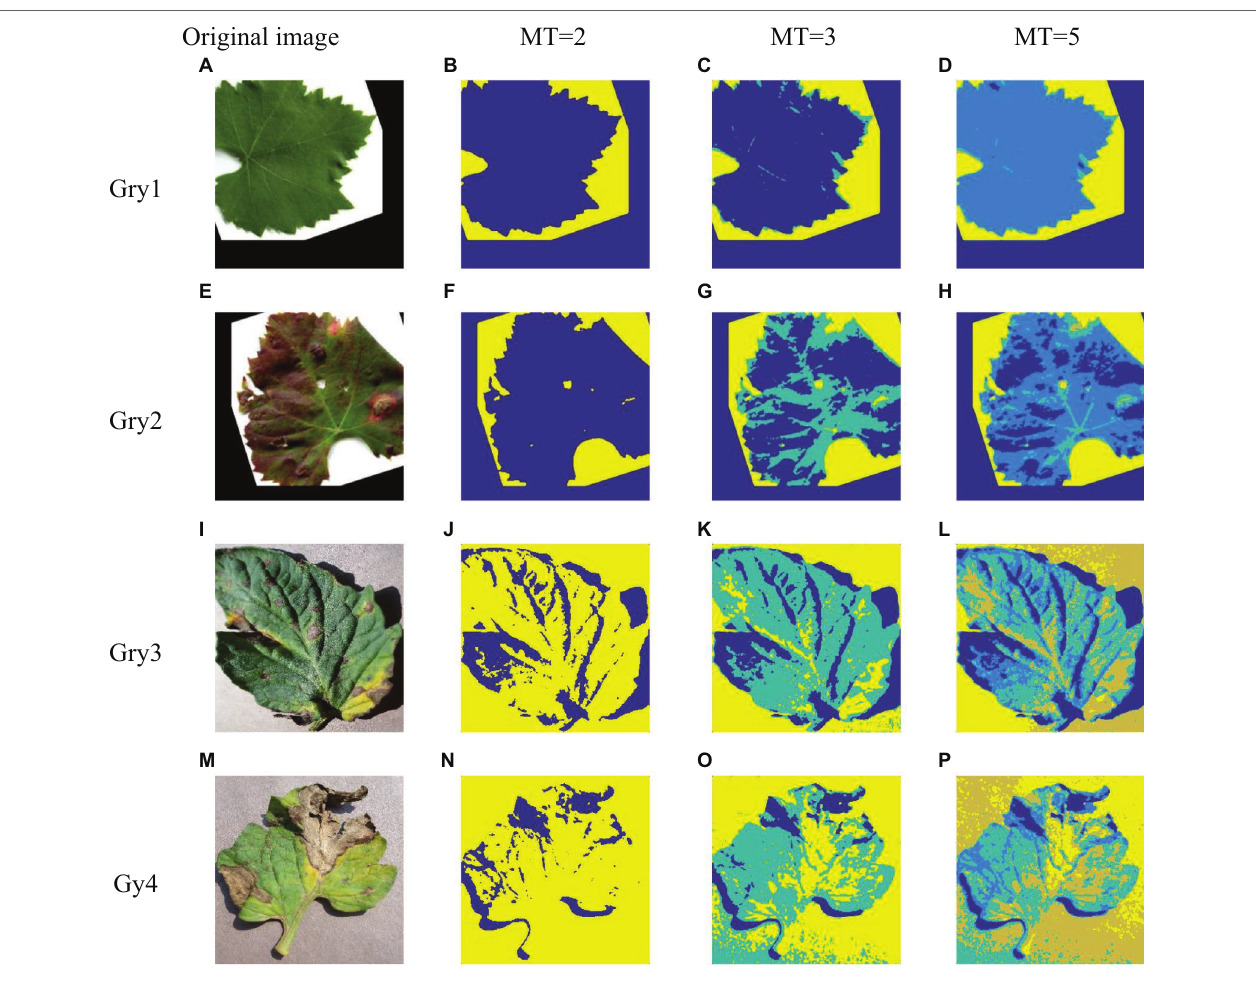
FIGURE 3 | The plant image segmentation result based on ISBO.